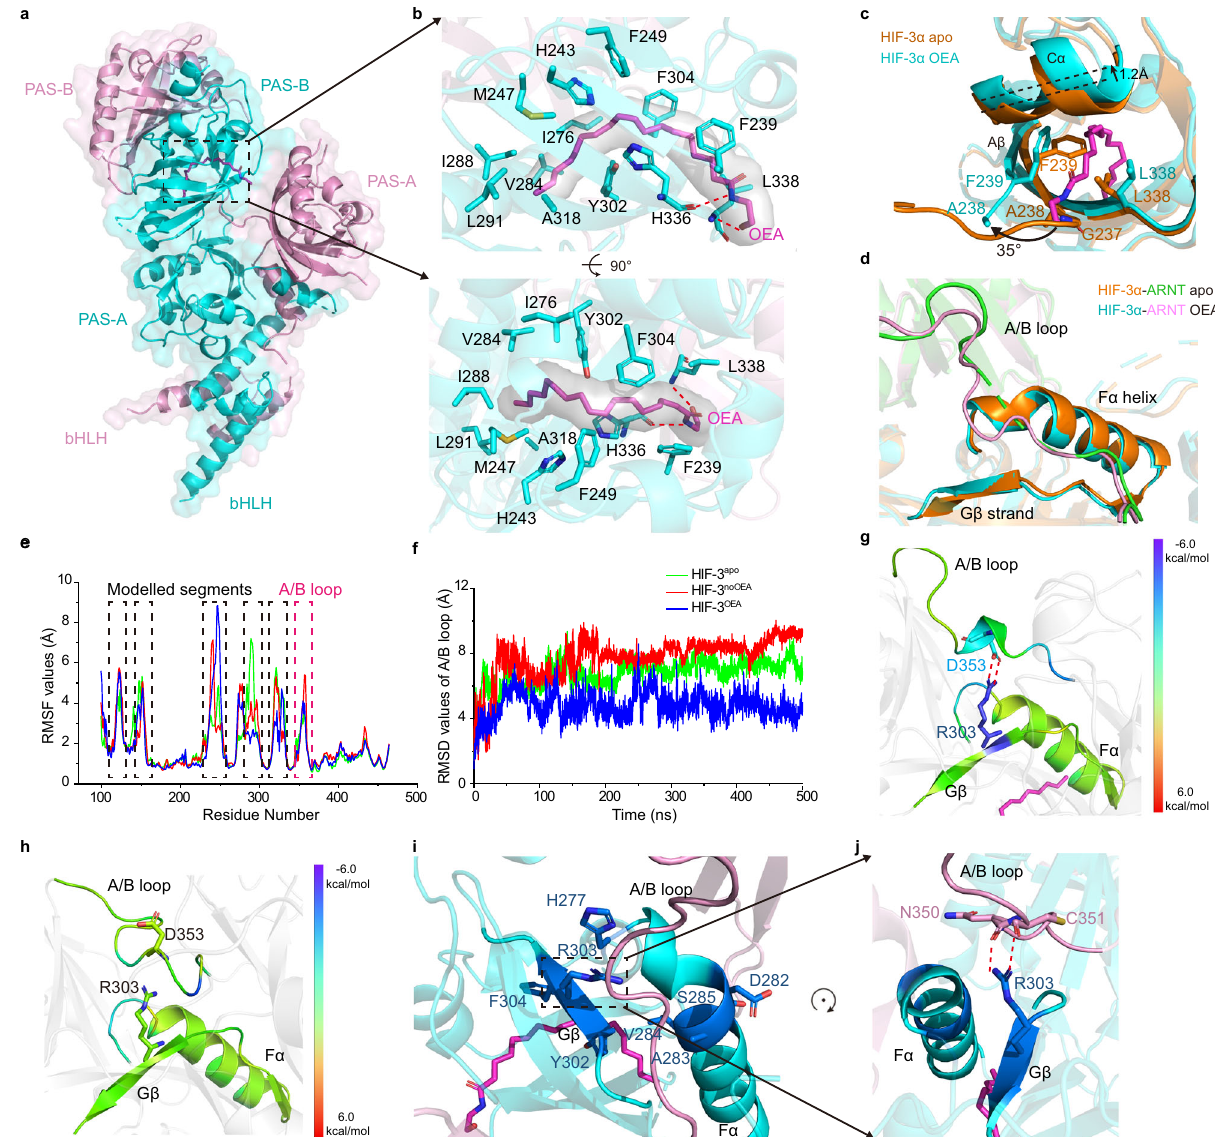
Fig. 3 The molecular mechanism of OEA on stabilizing the HIF-3 α -ARNT heterodimer. a Overall crystal structure of the HIF-3 α -ARNT in complex with bound OEA. HIF-3 α and ARNT are colored in cyan and pink, respectively. b An enlarged view of OEA (magenta) inside its binding pocket, with residues involved in the interaction shown as sticks. c , d Superimposition of HIF-3 α -ARNT structures with and without OEA, at the entrance position of HIF-3 α PAS- B domain ( c ) and the ARNT A/B loop ( d ), highlighting the conformational changes after OEA binding. HIF-3 α and ARNT proteins in the apo form are colored in orange and green, respectively. e C α RMSF plots for the ARNT subunit in each system. The highly fl exible domains including modelled linkers (black) and A/B loop (magenta) are highlighted. f C α RMSD plots for the ARNT A/B loop (residues 349-360) in each system. g , h Per-residue decomposition of relative binding energy for residues within the interface between ARNT A/B loop and HIF-3 α PAS-B domain in HIF-3 OEA ( g ) and HIF- 3 noOEA ( h ) systems, respectively. For each system, the 500-ns snapshot is shown. i , j HDX-MS results mapped on the F α and G β regions of HIF-3 α . The residues with signi fi cantly reduced deuteration levels upon OEA binding are colored in dark blue ( − 90 to − 50%) as compared to the apo form ( i ) (detailed in Supplementary Fig. 5a), and the R303 in G β of HIF-3 α forms hydrogen bonds with A/B loop of ARNT ( j ). Hydrogen bonds are shown in red dotted